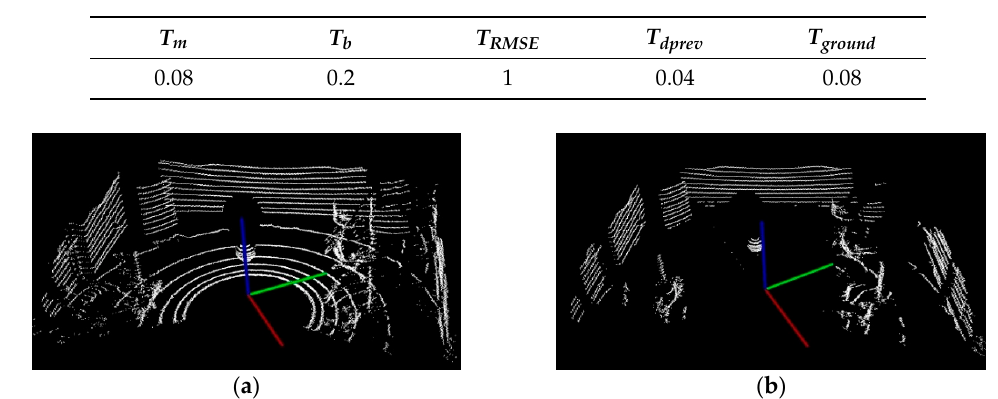
Figure 7. Results of fast ground segmentation: ( a ) Before segmentation; ( b ) After segmentation.